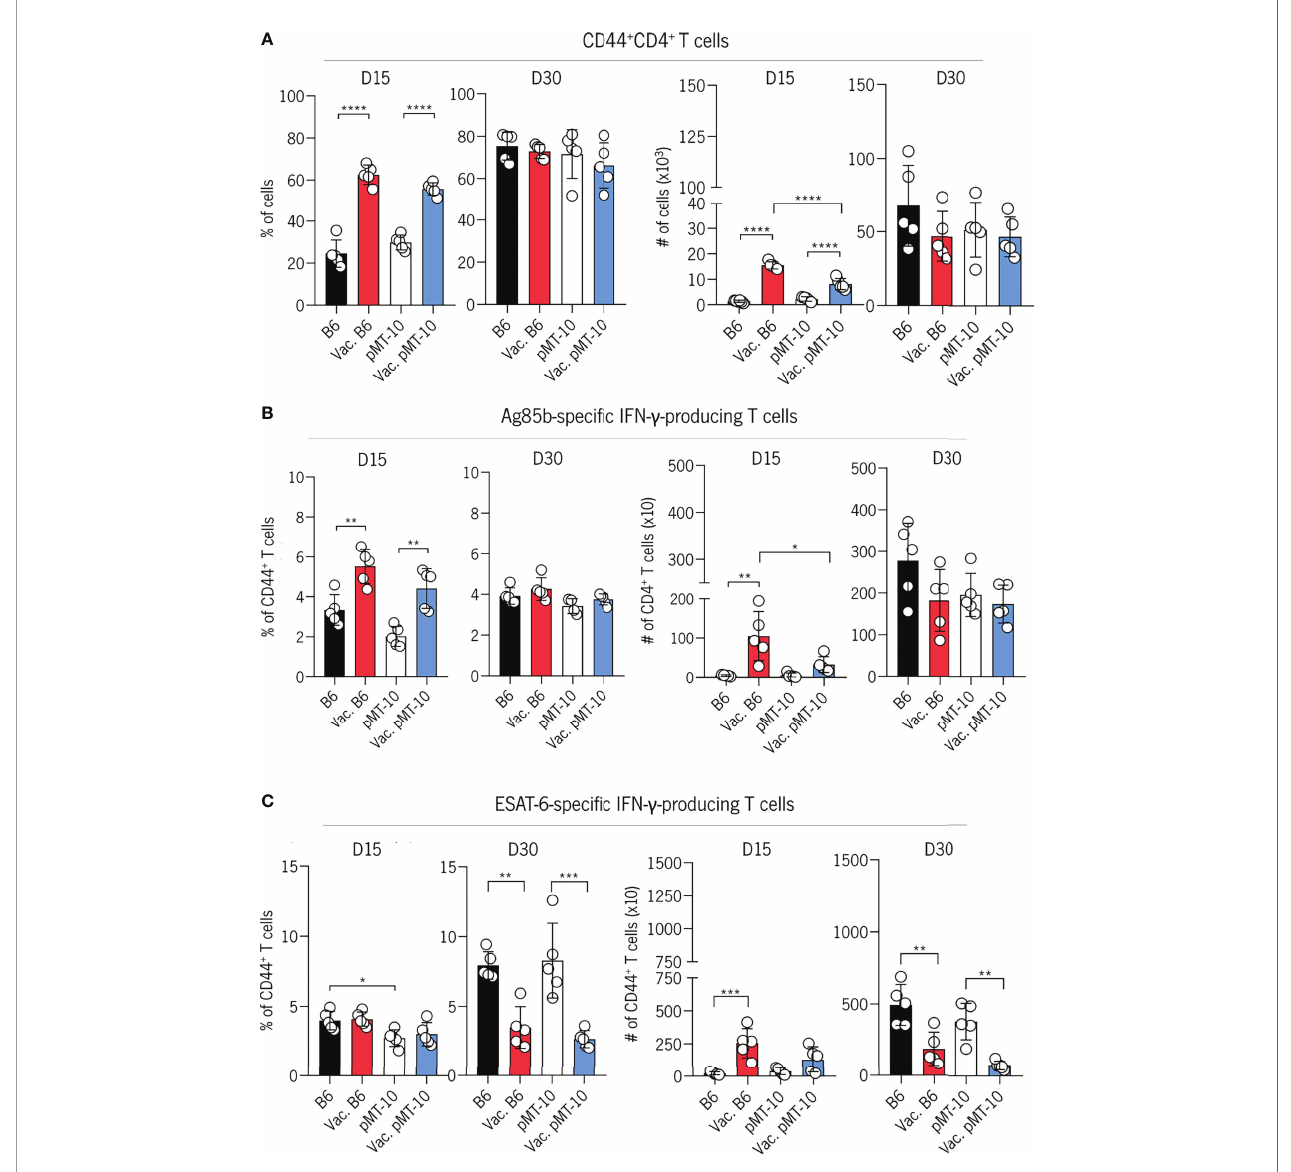
FIGURE 2 | IL-10 overexpression does not impair the early accumulation of BCG-induced CD4 + T cells in the lungs Mtb-infected mice. B6 and pMT-10 mice were subcutaneously vaccinated with 1 × 10 6 BCG. Unvaccinated mice were used as controls. Two months after vaccination, mice were infected with Mtb H37Rv via the aerosol route and IL-10 overexpression was initiated. (A) Frequency and number of CD4 + T cells expressing CD44 in the lungs of mice at days 15 and 30 postinfection. (B) Frequency and number of IFN- g – producing CD4 + T cells after in vitro restimulation with the Ag85b 240-254 peptide in the lungs of mice at days 15 and 30 postinfection. (C) Frequency and number of IFN- g – producing CD4 + T cells after in vitro restimulation with the ESAT-6 1 – 20 peptide in the lungs of mice at days 15 and 30 postinfection. Data represent one experiment out of two independent experiments performed, each with fi ve mice per group. *p < 0.05, **p < 0.01, ***p < 0.001, ****p < 0.0001 by one-way ANOVA followed by Tukey ’ s